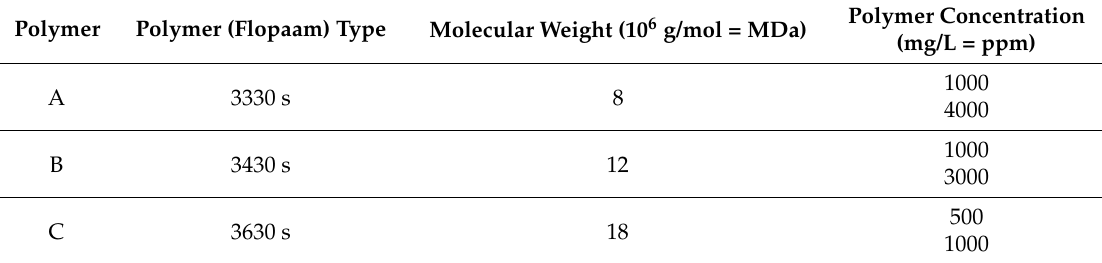
Table 1. Molecular weights and concentrations of